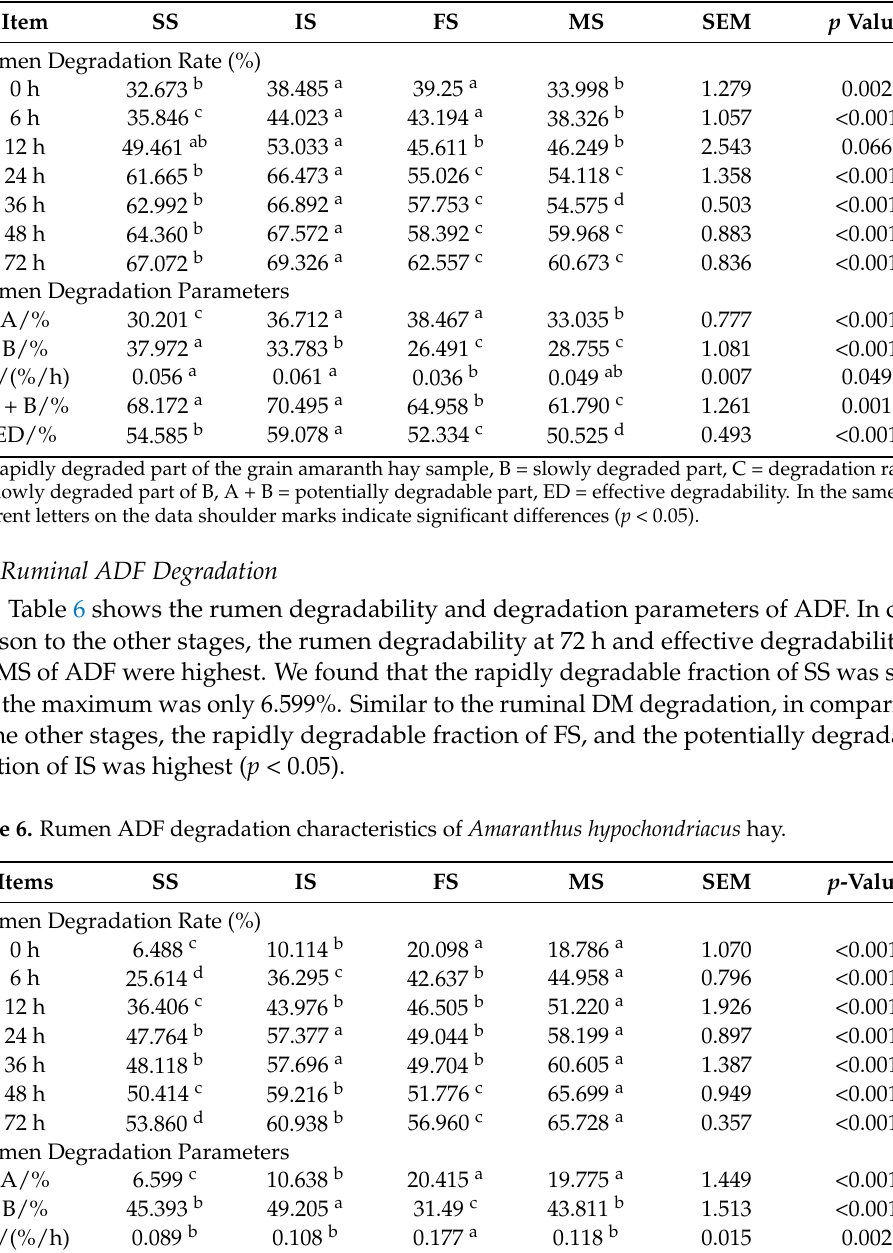
Table 5. Rumen NDF degradation characteristics of Amaranthus hypochondriacus hay.